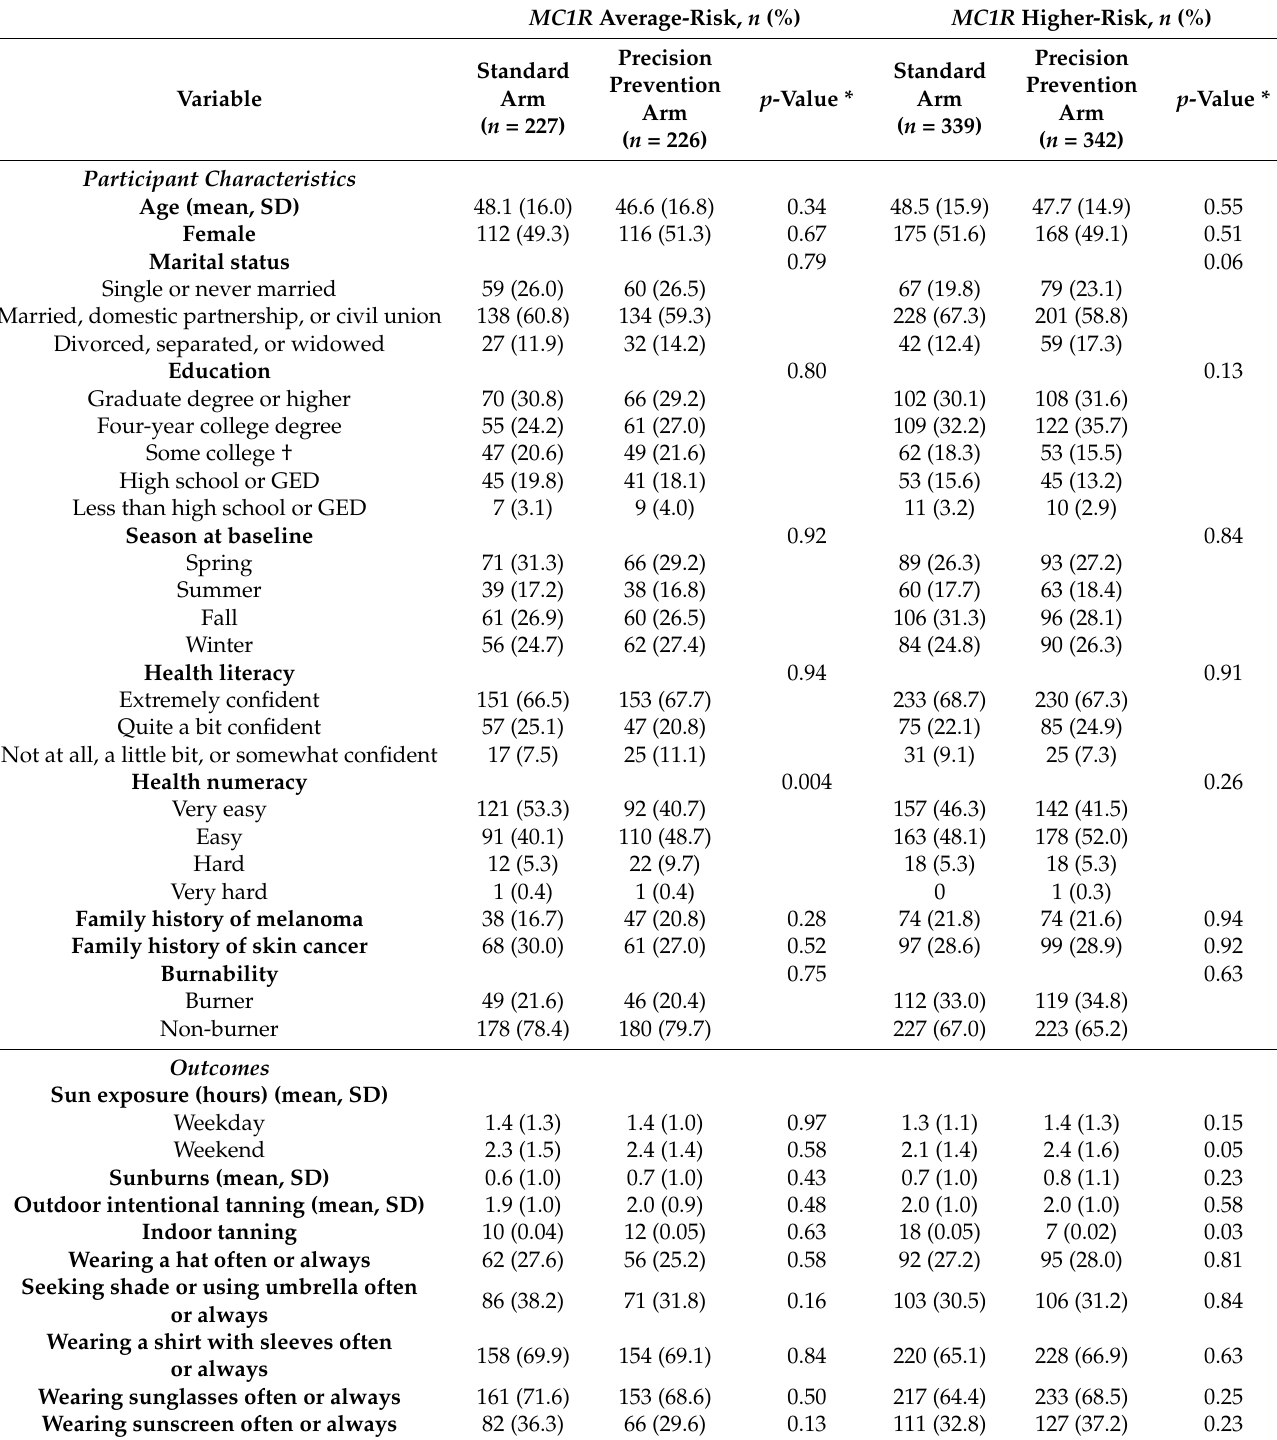
Table 1. Baseline characteristics of the study